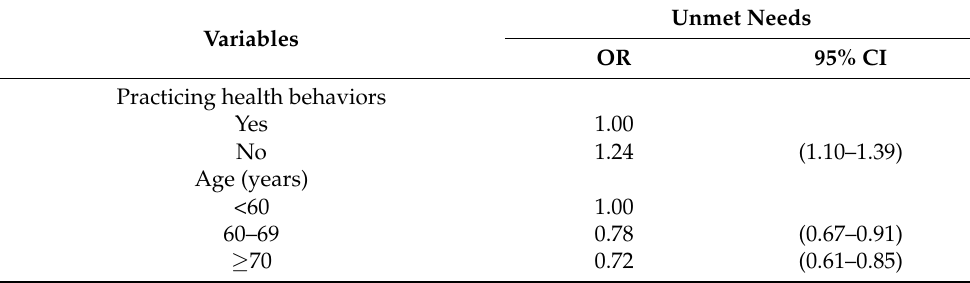
Table 2. Results of GEE analyzing the effect of practicing health behavior on unmet